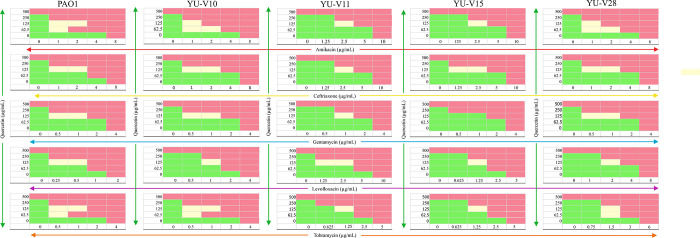
Checkerboard showing effect of antibiotic-quercetin combinations against P. aeruginosa strains.Pink color represents growth inhibition (additive/MIC), cream color indicates the synergistic effect with growth inhibition. Green shows no reduction in the growth (no effect) based on the visible turbidity. The P. aeruginosa strains were treated with fractional concentration of antibiotic with quercetin in 96-well MHB for 24 h. The growth based on visible turbidity was used for interpreting the results.